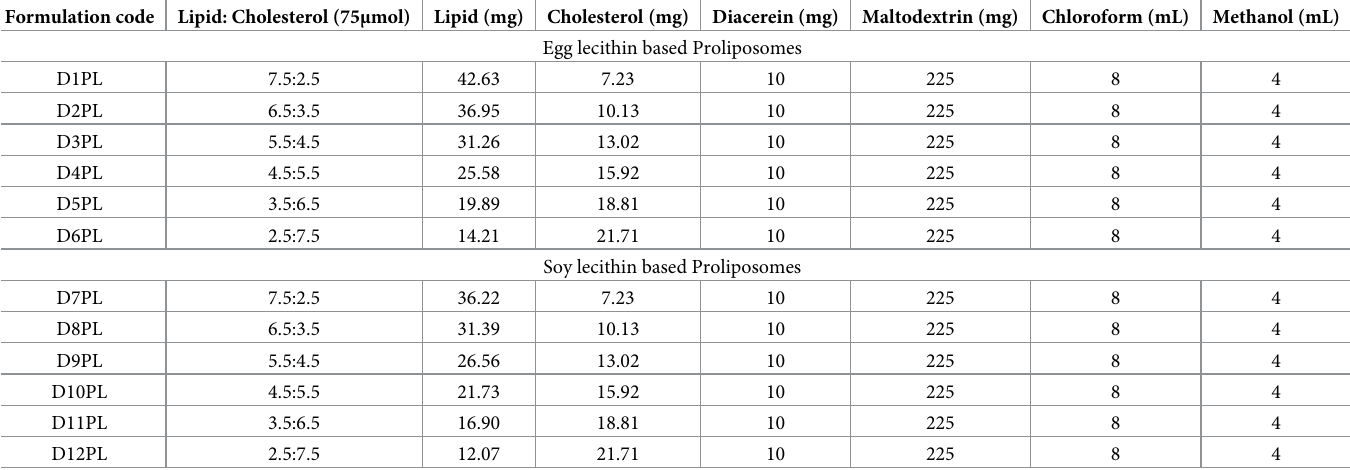
Table 1. Composition of diacerein loaded proliposomes of egg lecithin and soy lecithin. Formulation code Lipid: Cholesterol (75 μ mol) Lipid (mg) Cholesterol (mg) Diacerein (mg) Maltodextrin (mg) Chloroform (mL) Methanol (mL) Egg lecithin based